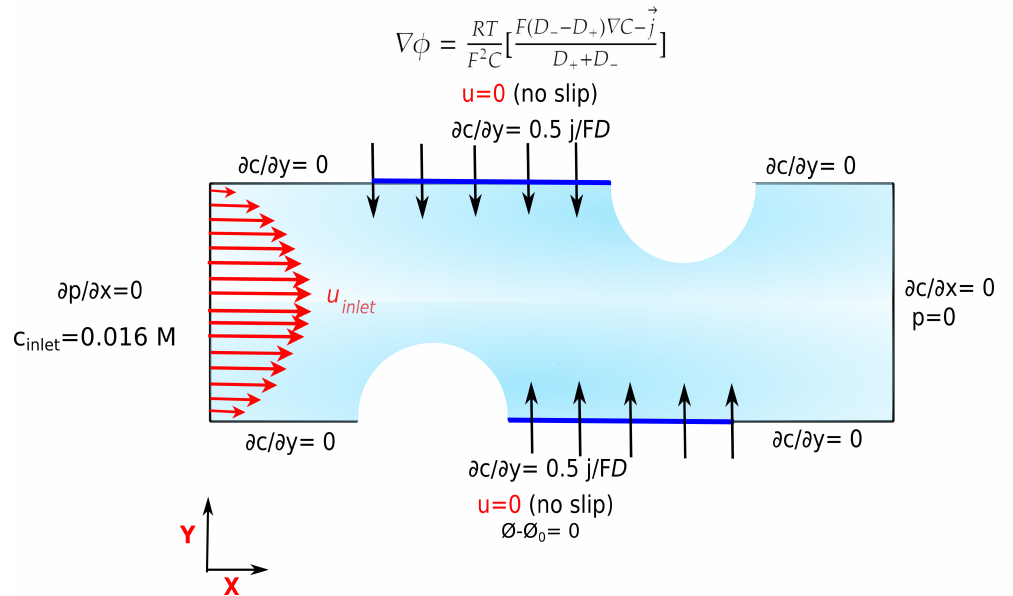
Figure 3. The boundary conditions for a section of dilute, non-conductive cylindrical spacer-filled channel. The blue line shows the active membrane section and the arrows show the diffusion direction from the top and bottom wall toward the dilute bulk. The geometry is repeated to build the full length of the